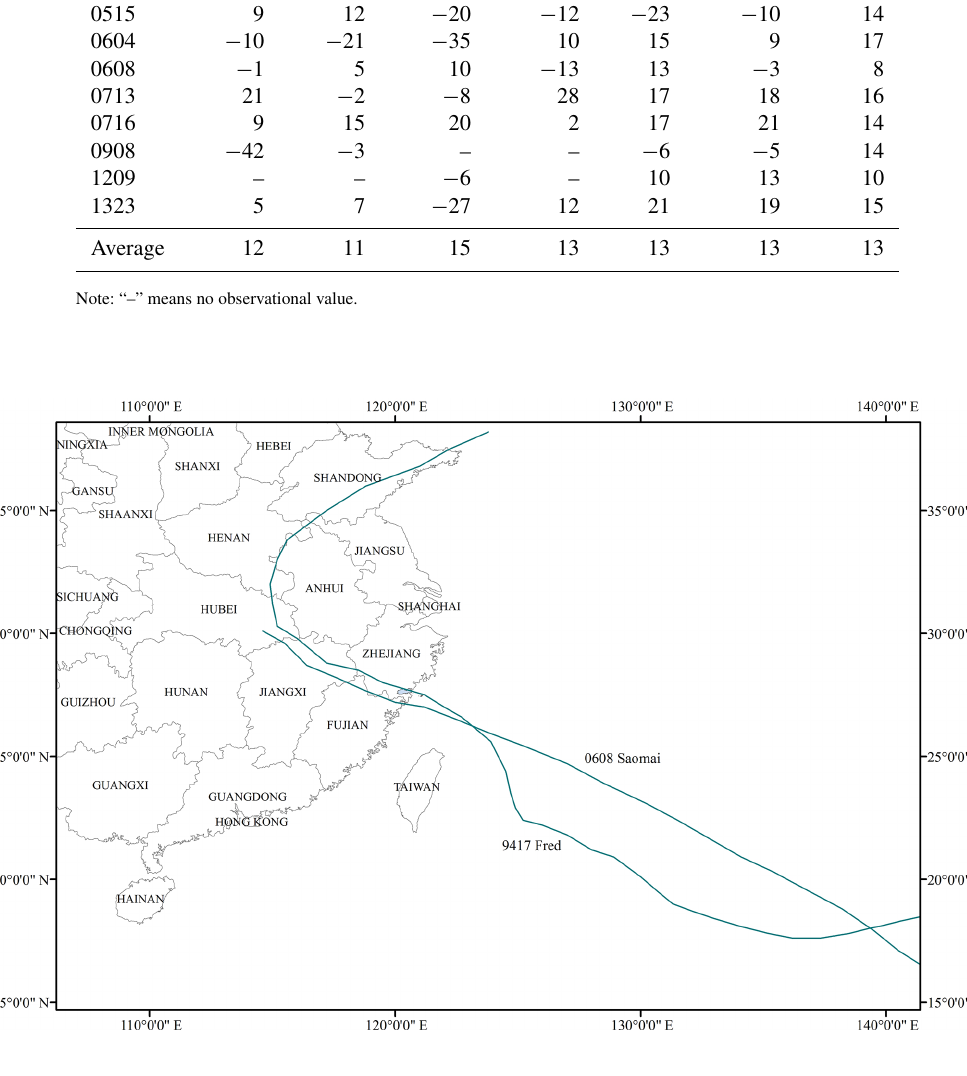
Figure 8. Typhoon tracks of 9417 Fred and 0608